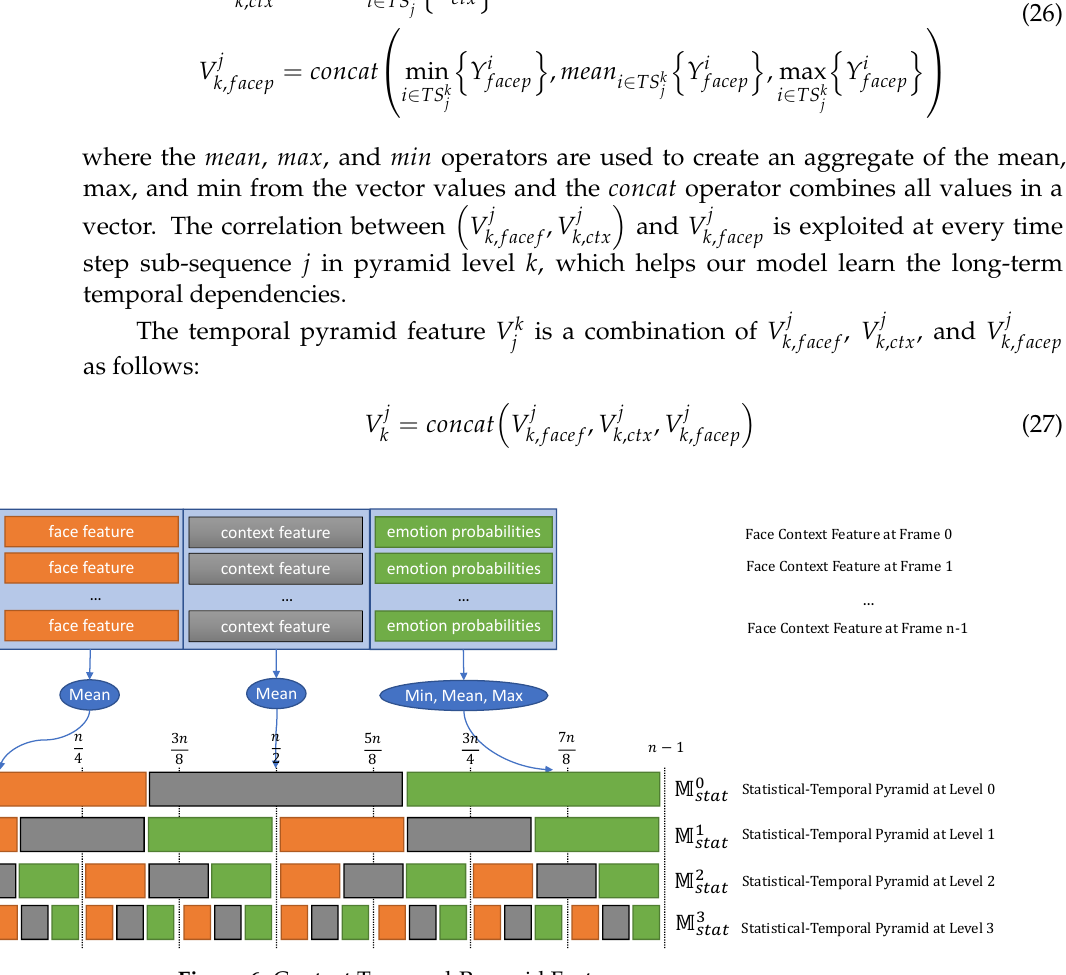
Figure 6. Context Temporal-Pyramid